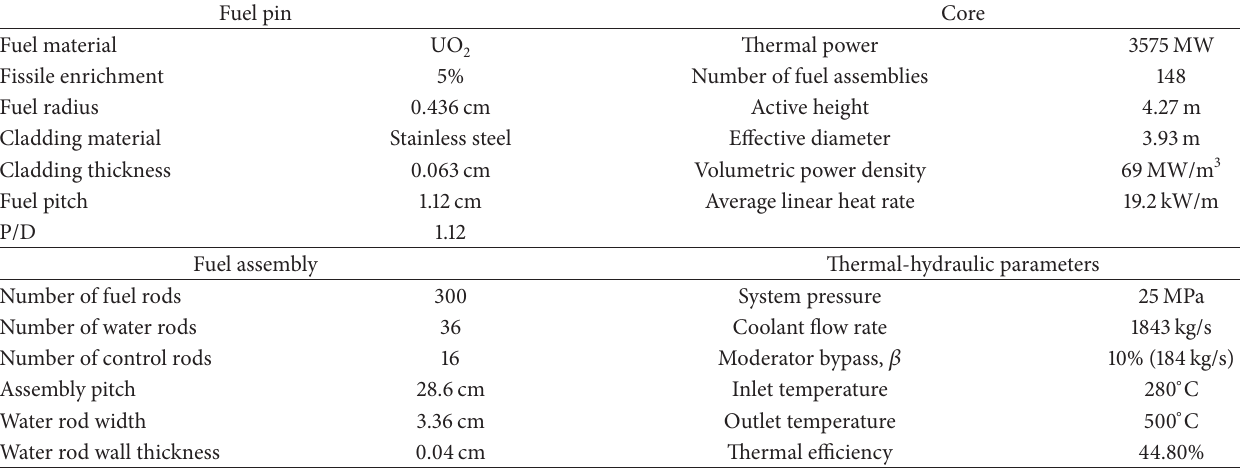
Table 1: SCWR nominal design parameters (Buongiorno et al., 2003 [3]).